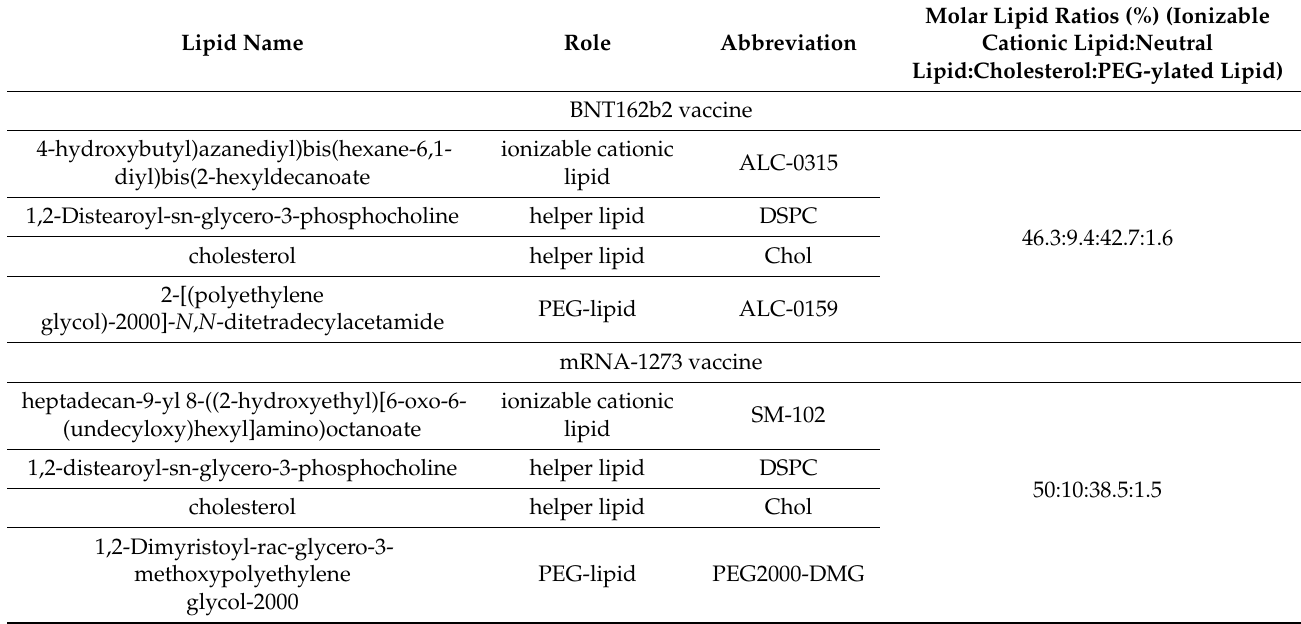
Table 5. LNP carriers of the COVID-19 mRNA vaccines (lipidic constituents)